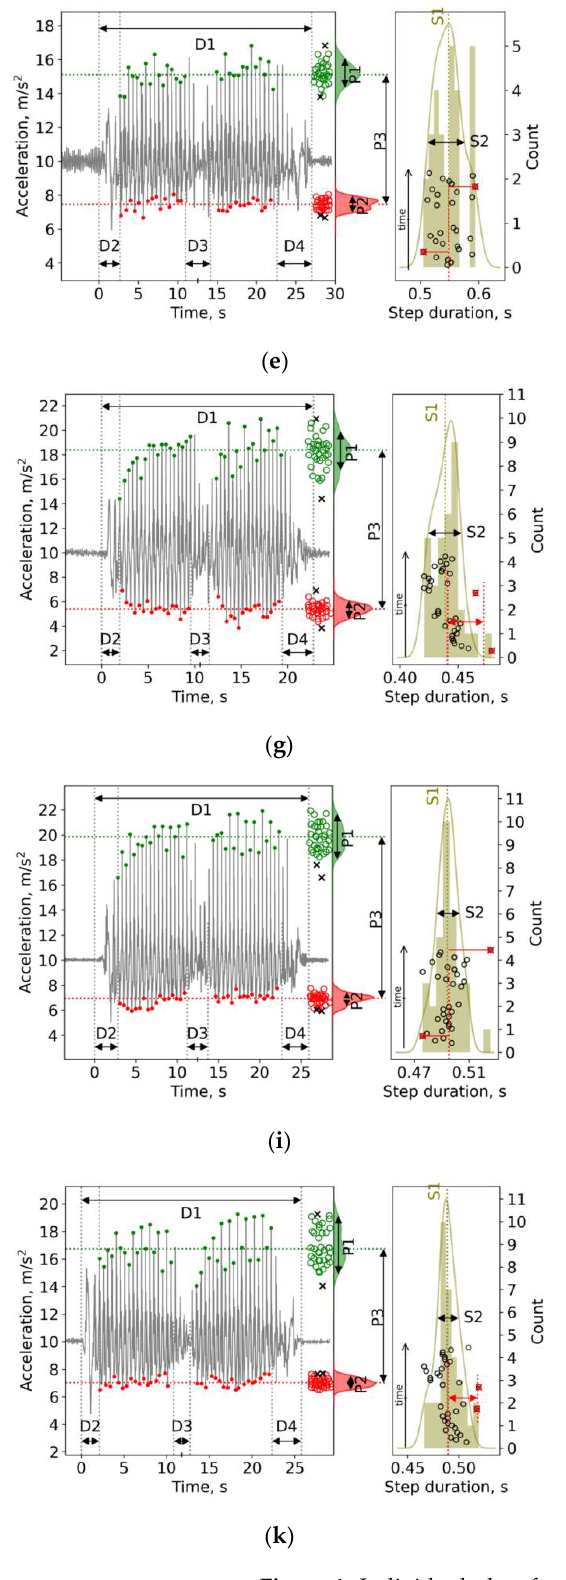
Figure 4. Individual plots for six courses of DI sessions in five subjects. For details, see Figure 2: ( a ) Subject 1 before and ( b ) after the 1st course of DI; ( c ) Subject 1 before and ( d ) after the 2nd course of DI; ( e ) Subject 2 before and ( f ) after the course of DI; ( g ) Subject 3 before and ( h ) after the course of DI; ( i ) Subject 4 before and ( j ) after the course of DI; ( k ) Subject 5 before and ( l ) after the course of